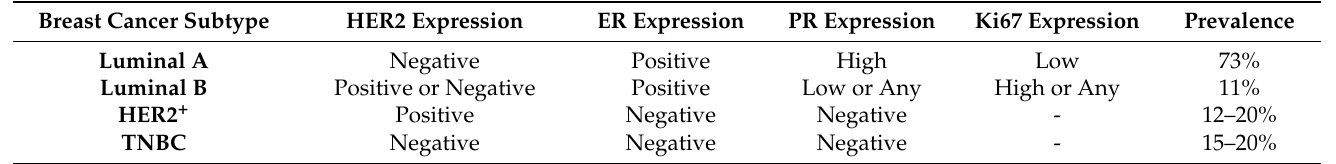
Table 1. Molecular classification and prevalence of breast cancer